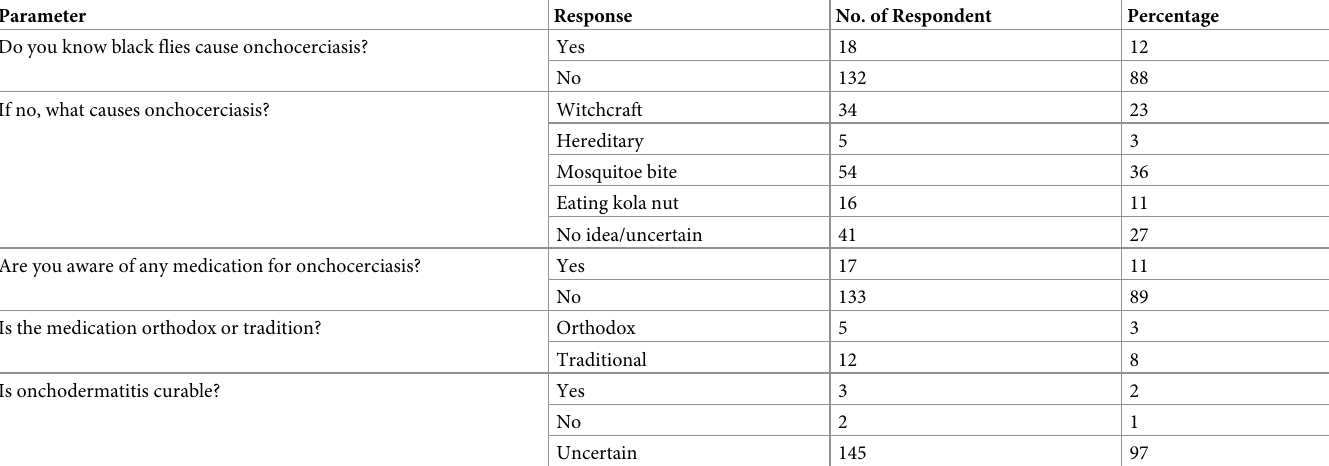
Table 3. Knowledge of respondents on onchocerciasis, causes and